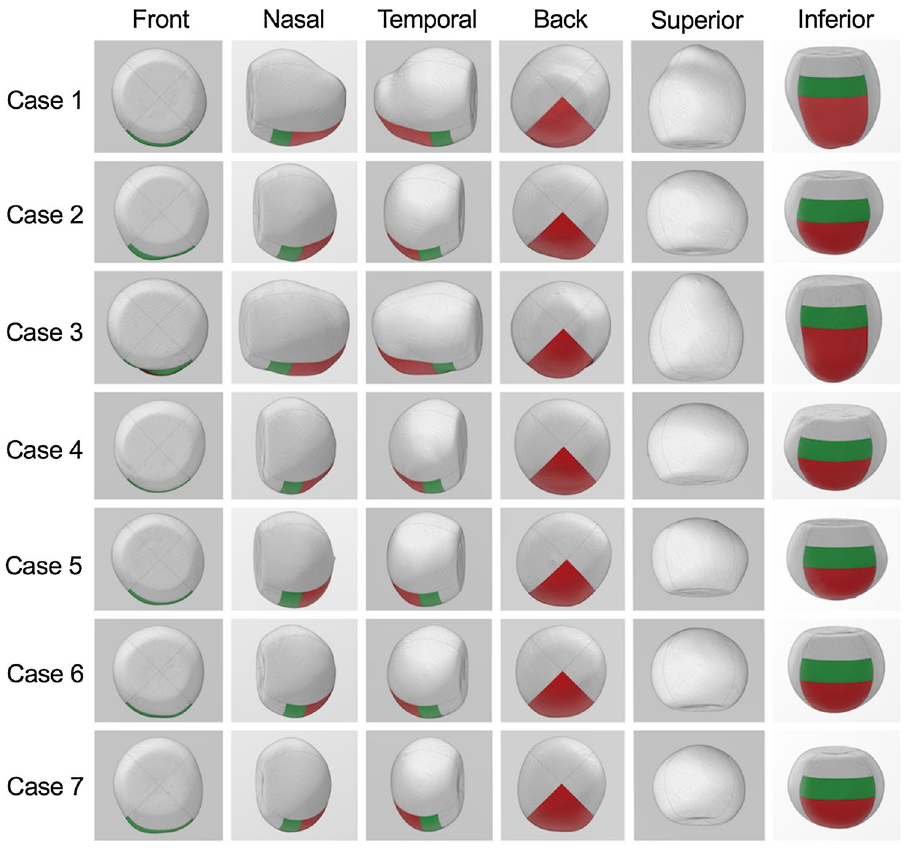
Figure 3. Three-dimensional vitreous cavities of all the cases. In all the cases, the inferior-anterior and inferior- posterior retina are painted green and red, respectively.